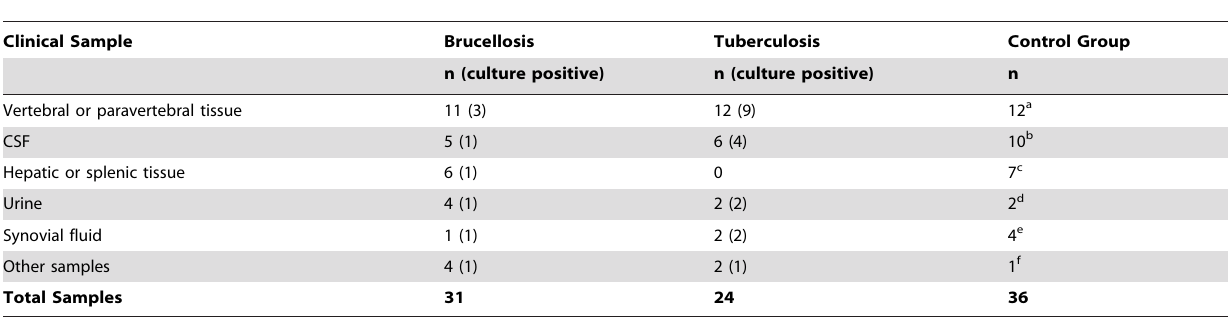
Table 2. Sample type and diagnosis of the study